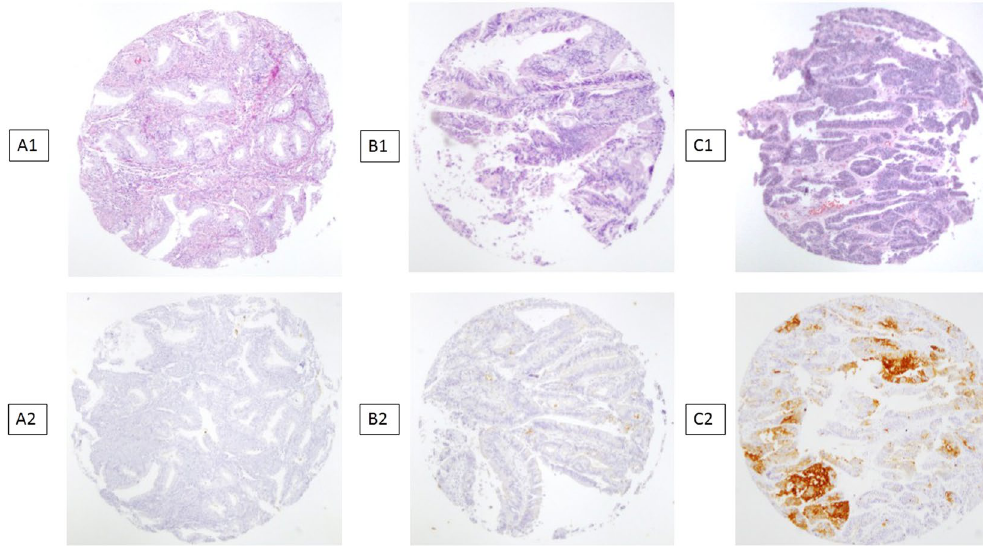
Figure 1. Endometrioid adenocarcinoma of the endometrium. A1 B1 C1: HE * 10. Glandular neoplastic endometrioid tumor. A2: CD133 − immunostaining. endometrioid endometrial carcinoma grade 1.